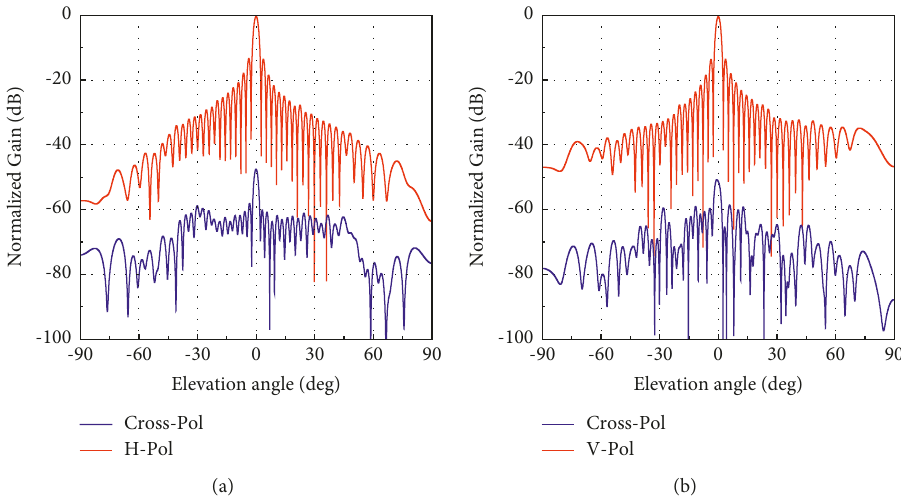
Figure 3: (a) Measured H-polarization pattern and cross-polarization. (b) Measured V-polarization pattern and cross-polarization.